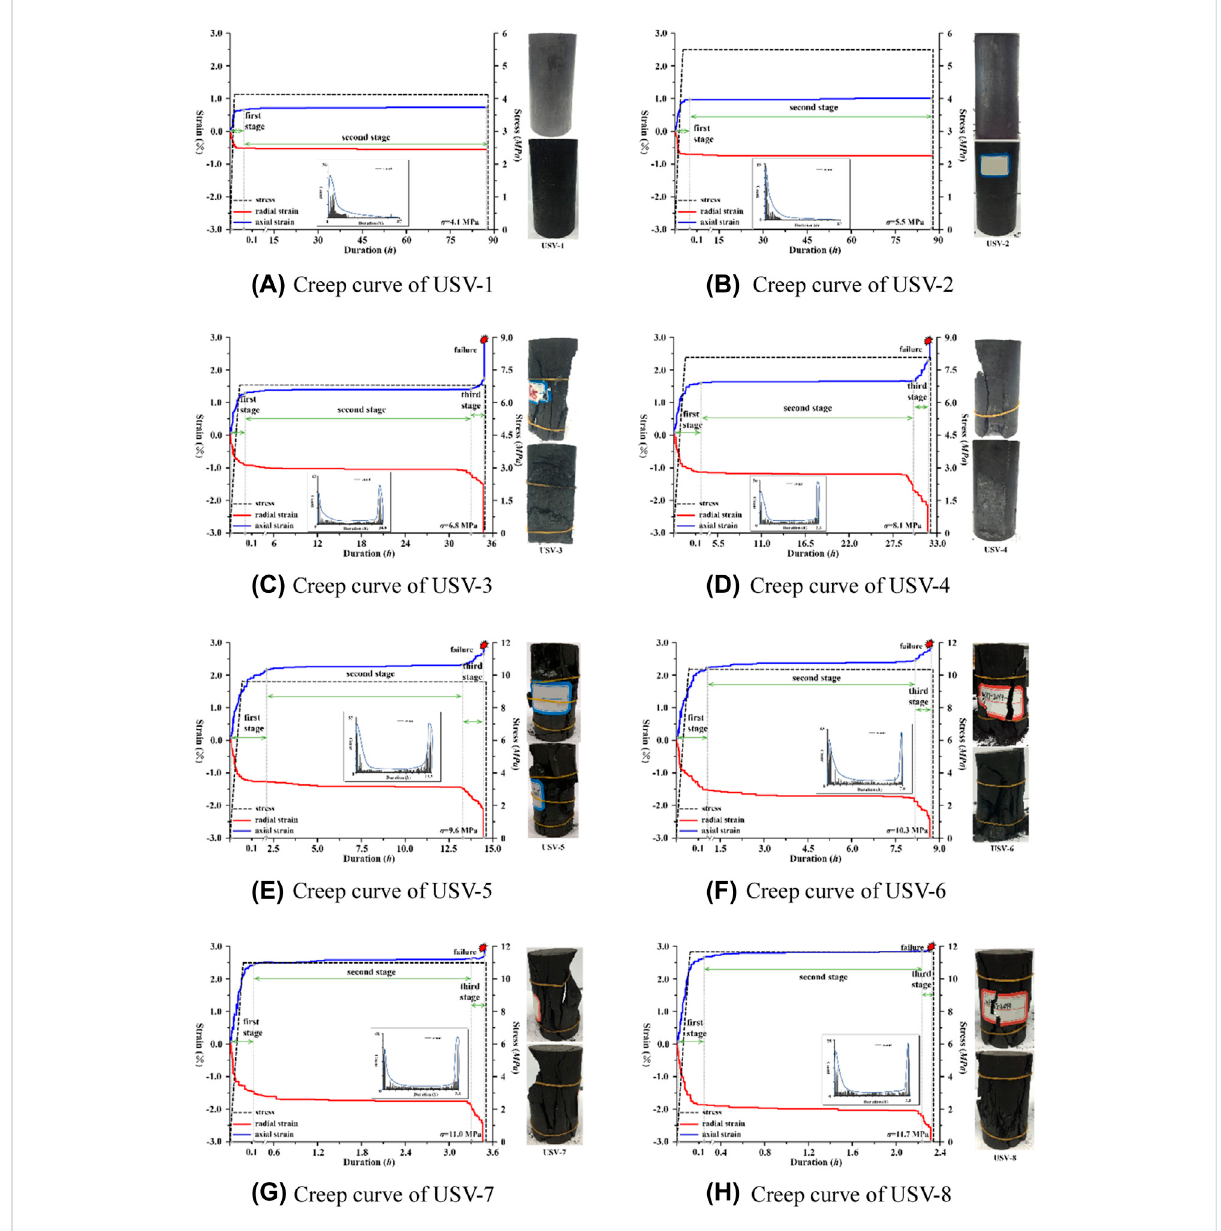
FIGURE 7 Laboratory fi ndings of USV group